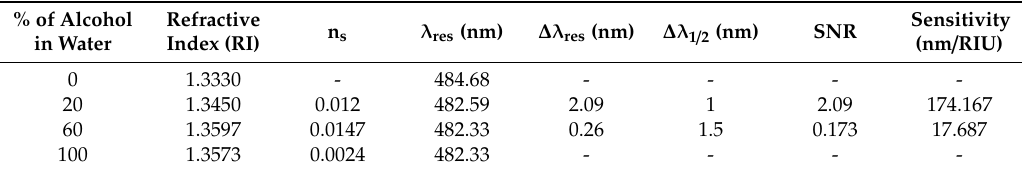
Table 2. Ag–surface plasmon resonance (Ag–SPR) sensor: sensitivity and signal-to-noise ratio (SNR) comparison.